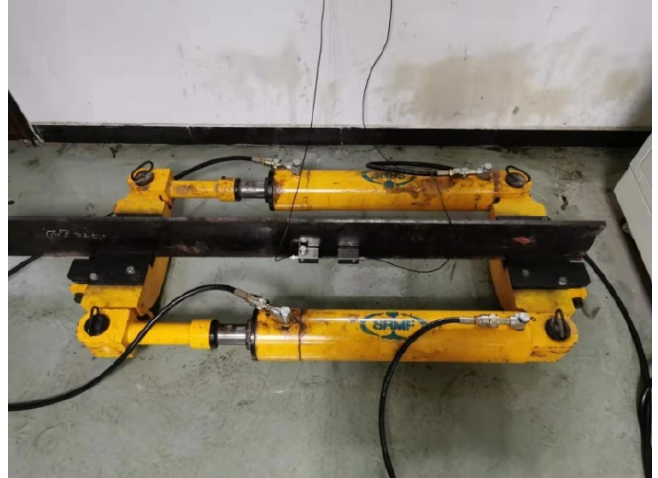
Figure 14. Steel plate tensile test system.